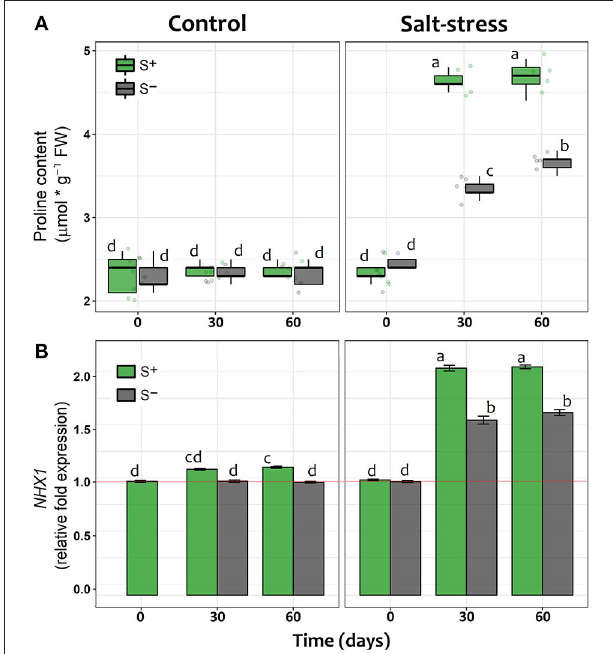
FIGURE 3 | (A, B) Proline concentration (mmol/g FW) and, relative fold gene expression of NHX1 in shoot tissue of lettuce plants measured at 0, 30, and 60 days after exposed to salt stress (200mM NaCl for “stressed” individuals) and inoculated with the Antarctic microbial consortium (S + plants). Control groups for both conditions (non-stressed and non-inoculated, S–) are also showed. The relative expression increases are referred to the mean levels of expression in control lettuce plants (i.e., non-stressed and non-inoculated) at time 0, indicated by a red line. The box-plot represents the interquartile distribution of the data for each experimental group. Error bars at the NHX1 plot represent ± SE values. Different letters indicate significant a posteriori differences (Tukey test, α <